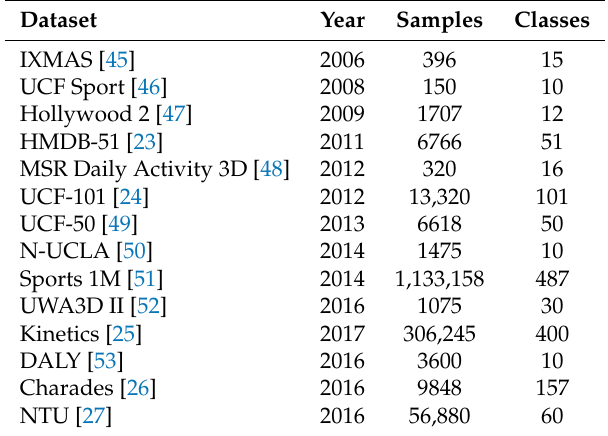
Table 2. List of the main RGB datasets used in human action recognition research